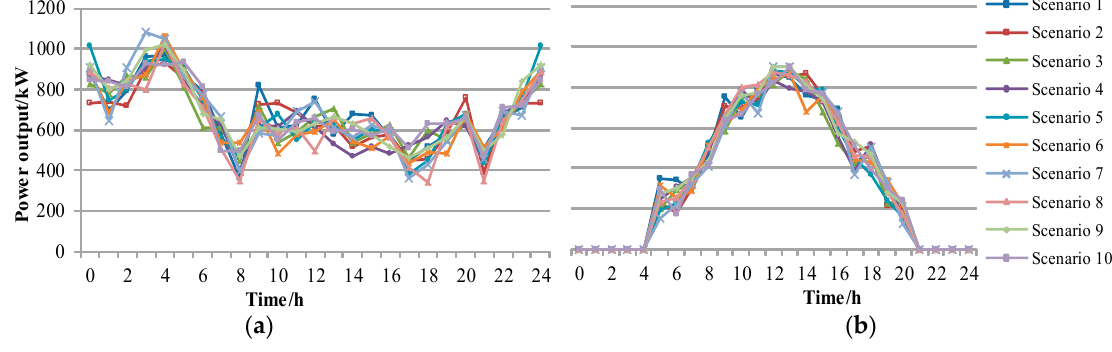
Figure 7. Typical simulation scenarios of wind turbine (WT)( a ) and photovoltaic (PV)( b ).